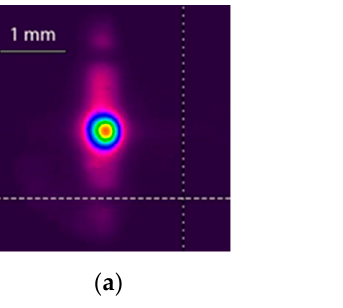
Figure 2. ( a ) Beam profiler image of the focal spot obtained with UV converter and ( b ) normalized distributions of intensity (red curve) and energy fraction (blue curve) in the focal spot.